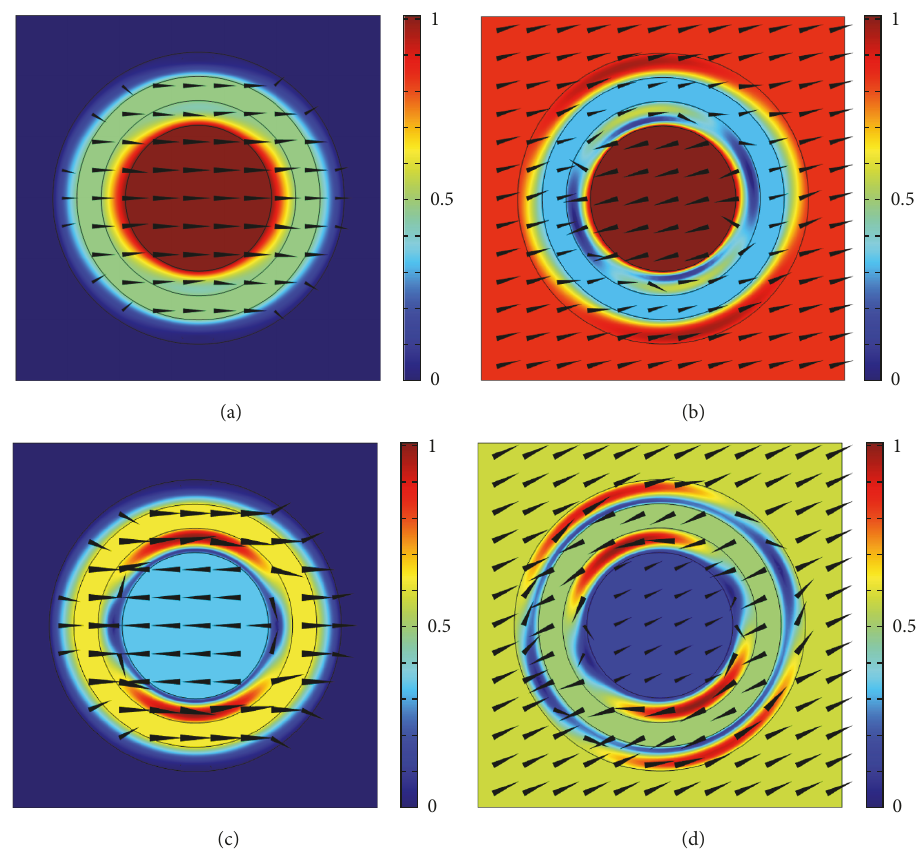
Figure 5: Vibration modes at the lower edge (a) and upper edge (b) of the first band gap; vibration modes at the lower edge (c) and upper edge (d) of the second band gap of the dual-oscillator acoustic metamaterial system. The color bar represents the normalized